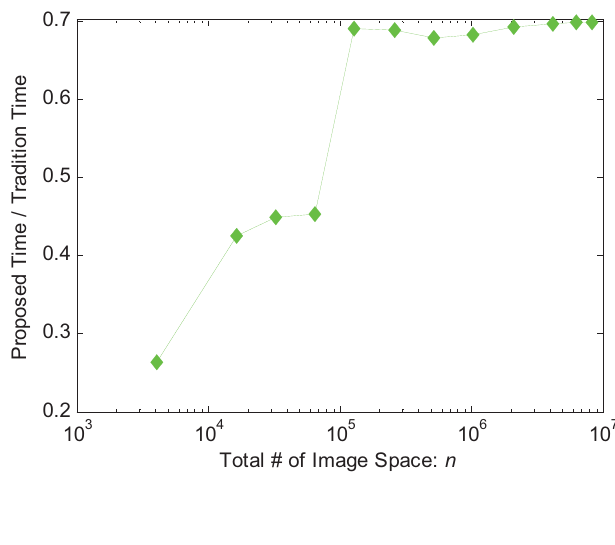
Figure 8. Comparison of the computation times between the proposed method and the traditional method. The x-axis denotes the total number of image voxels, and the y-axis denotes the ratio of computation times of the proposed method to traditional method. We used logarithm scale for